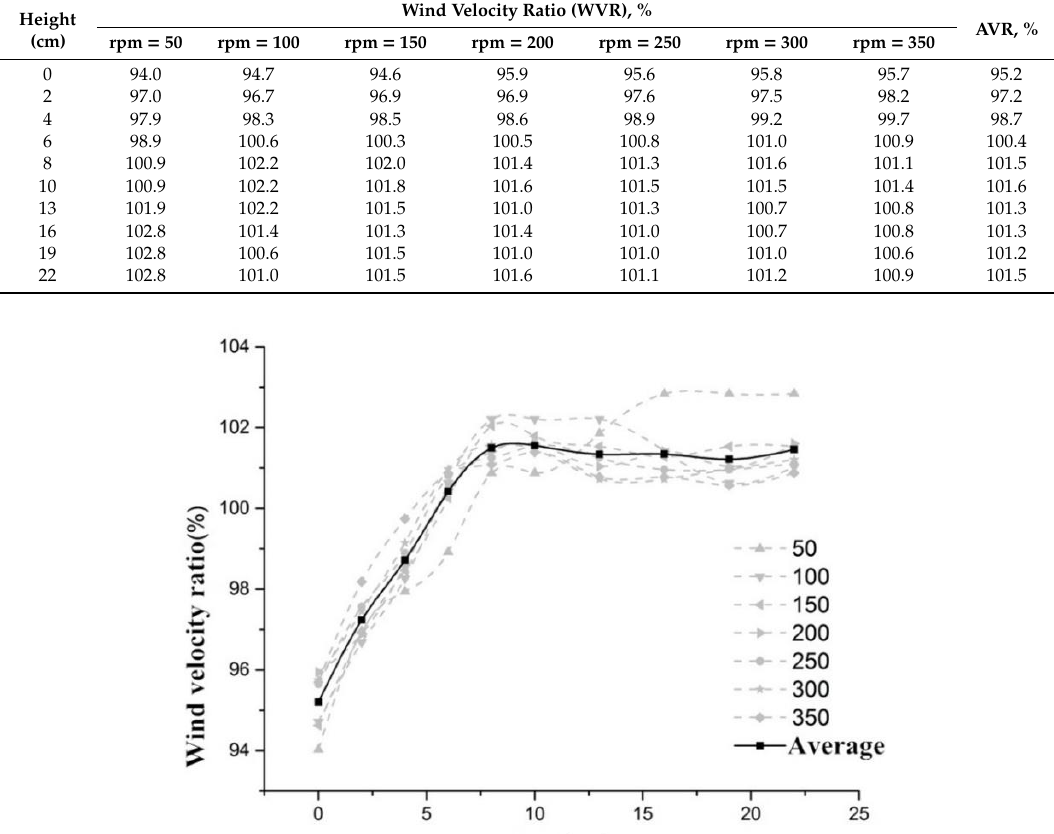
Table 2. Wind velocity ratio (WVR) and average velocity ratio (AVR) under di ff erent motor rotation speeds.